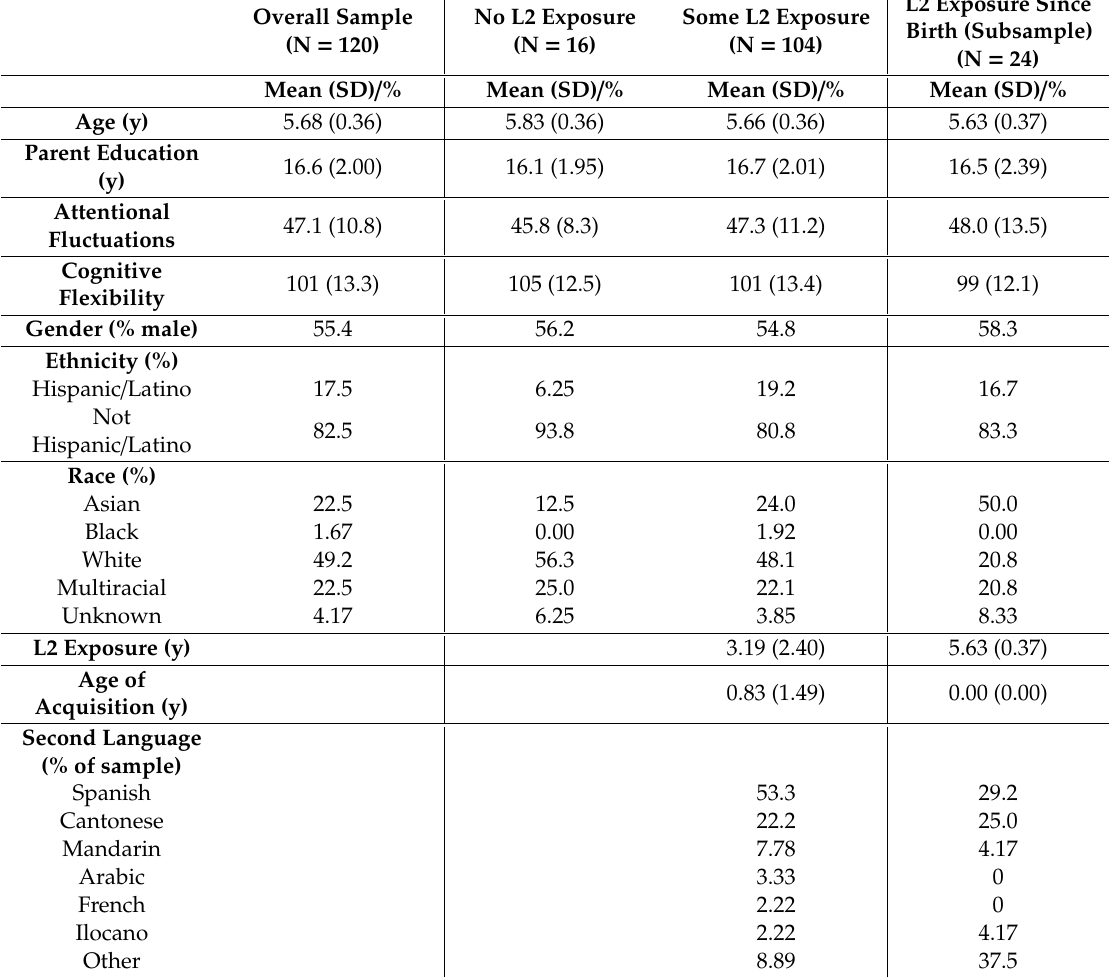
Table 1. Descriptive statistics for covariates and variables of interest in the overall sample and by language exposure group. Specifically, we compare individuals with some level of L2 exposure (N = 104), and of these, individuals who have been exposed to L2 since birth (N = 24), compared to individuals with no L2 exposure (N = 16) and the overall pooled sample (N =